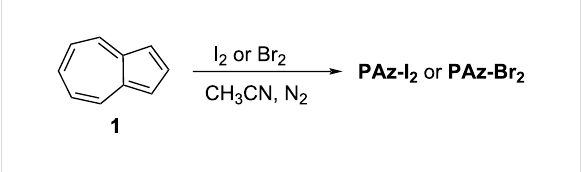
Scheme 1: Synthesis of polyazulene-iodine ( PAz-I 2 ) and polyazulene - bromine ( PAz-Br 2 ) complexes.